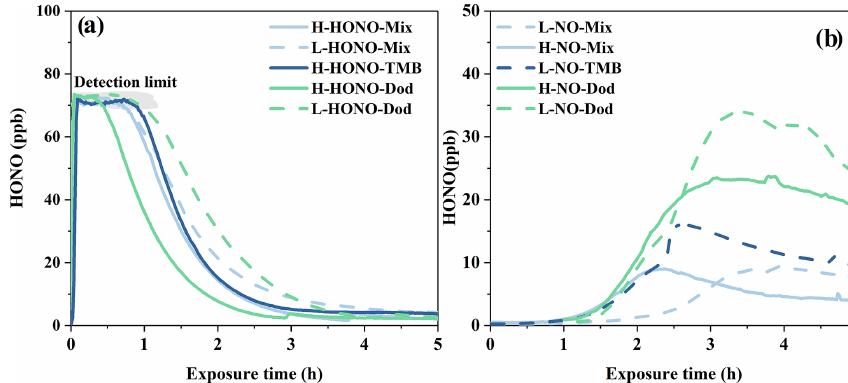
Figure 4. HONO concentration versus time during conducted experiments.